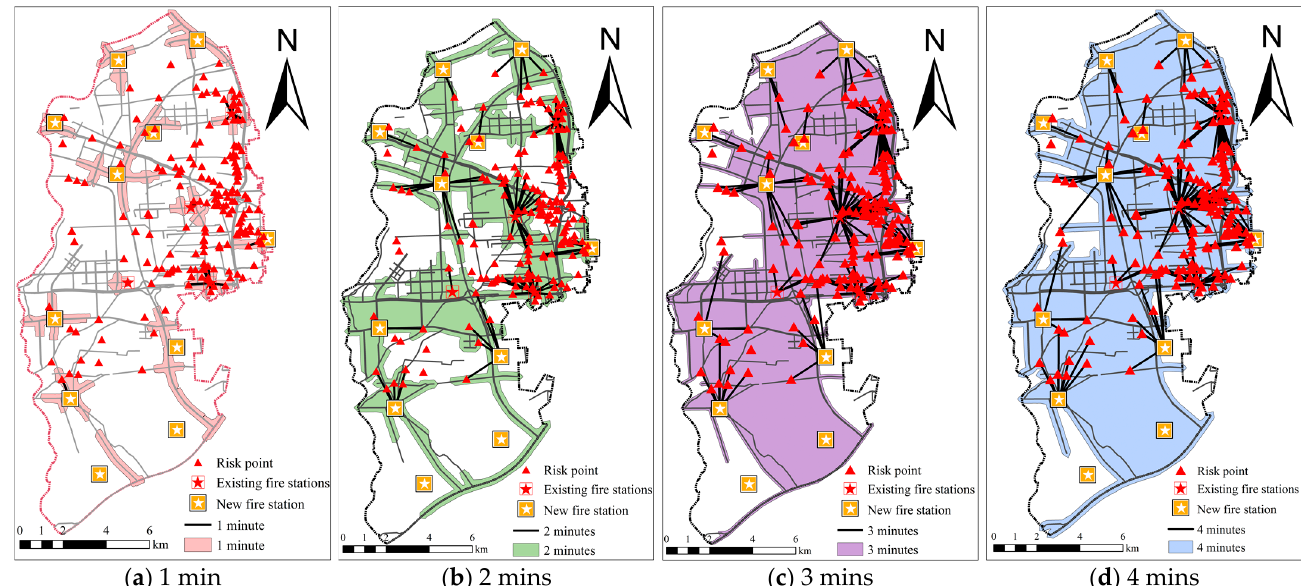
Figure 12. Coverage at each